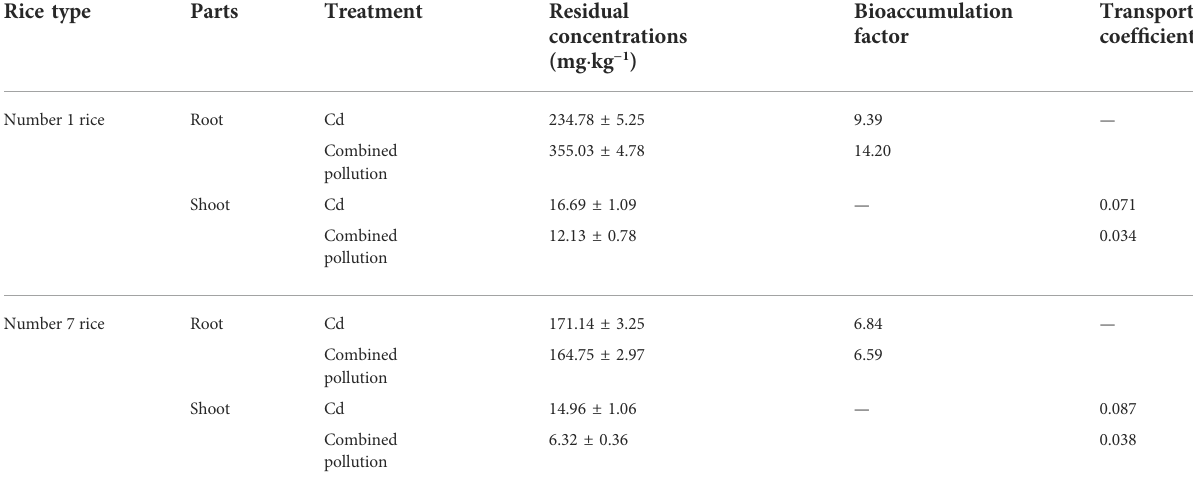
TABLE 4 Bioaccumulation and biological transport of cadmium in rice